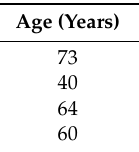
Table 1. Human DRG donor